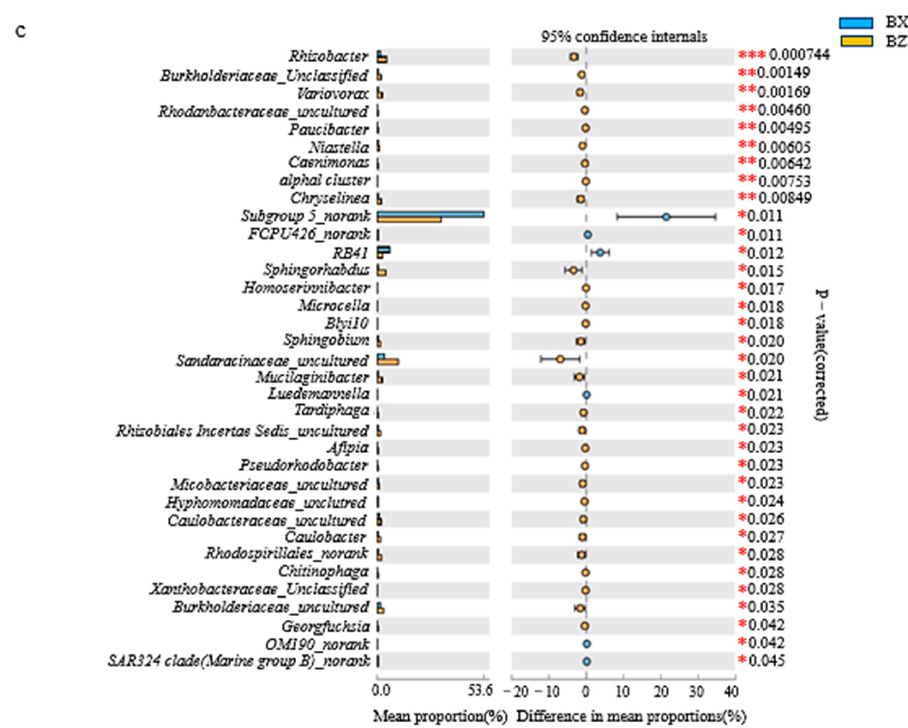
Figure 3. Differential analysis of the horizontal abundance of bacterial genera in litter. ( a ) Difference in bacterial abundance between litter layer of the Korean pine plantation and the original Korean pine forest; ( b ) different bacterial genera between the middle and lower litter layers in the Korean pine plantation; ( c ) different bacterial genera between middle and lower litter layers in the original Korean pine forest. *, significant difference between the two groups of data ( n = 3, p < 0.05); **, very significant difference between the two groups of data ( n = 3, p < 0.01); ***, very significant difference between the two groups ( n = 3, p < 0.001).